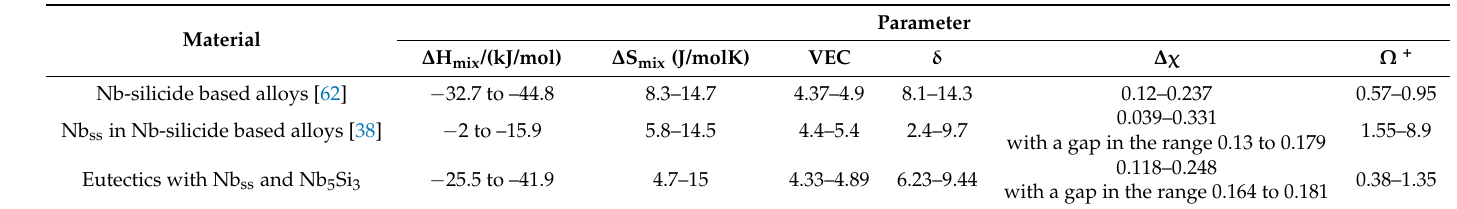
Table 1. Values of the parameters ∆ H mix , ∆ S mix , valence electron concentration (VEC), δ , ∆ χ , and Ω for all of the Nb-silicide based alloys and their solid solutions, and for the eutectics with Nb ss and Nb 5 Si 3